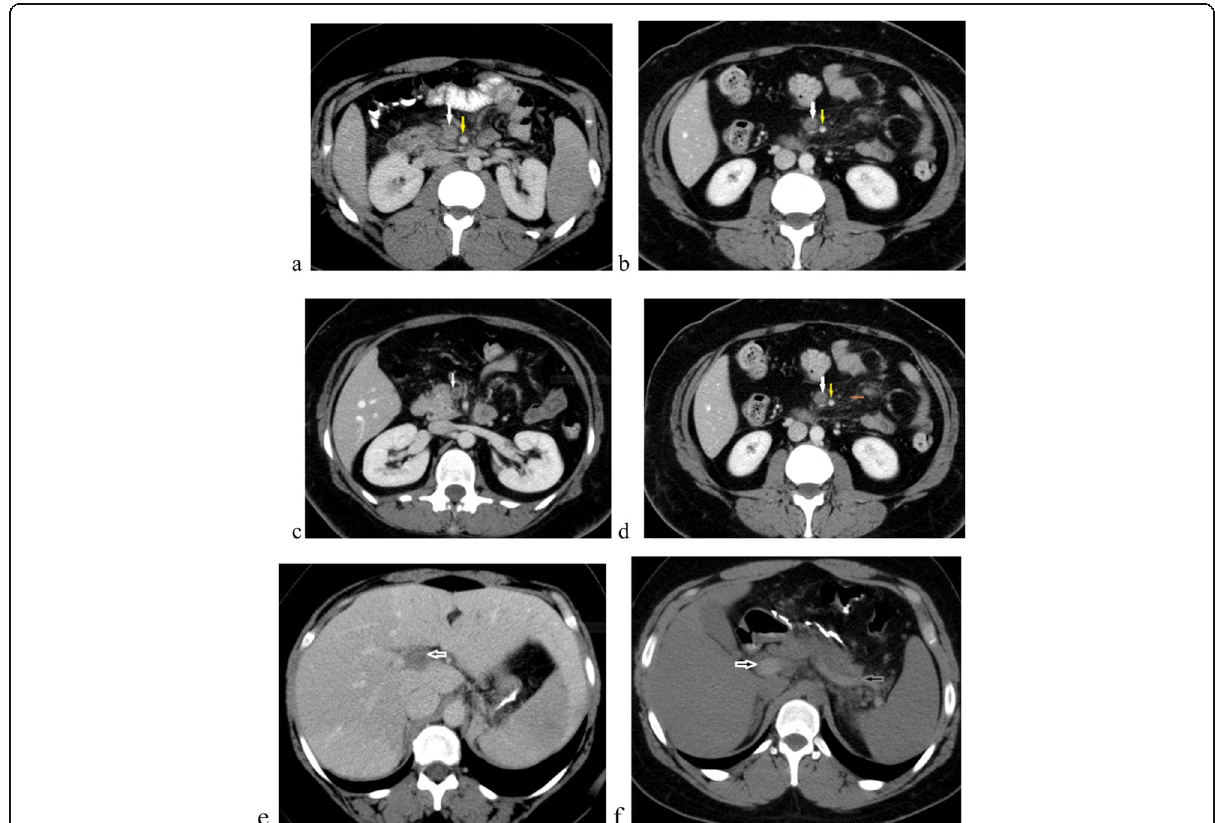
Fig. 11 A twenty-six-year-old male patient presented 1.5 years post-lap. sleeve gastrectomy by severe abdominal pain. a – d MSCT scans shows SMV thrombosis (white arrow). Note the normal SMA (yellow arrow) enhancement and ratio of SMV to SMA diameters > 2 and increased density of the surrounding fat (brown arrow). Portal and splenic veins thrombosis post-LSG. e MSCT scan axial cut with IV contrast showing non- enhanced portal vein (arrowed). f MSCT scan without intravenous contrast hyperattenuating splenic and portal vein. UGSI shows no abnormality. MSCT diagnosis: thrombosed portal, superior mesenteric and splenic